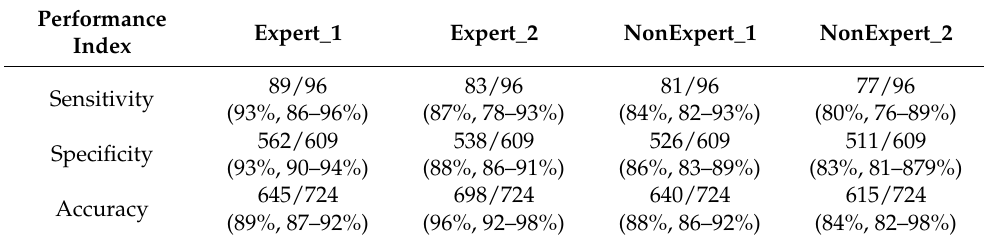
Table 3. Per-breast diagnostic performance of stand-alone DWI in 724 breasts in 382 women. Data in parentheses represent percentages and their 95% confidence intervals.